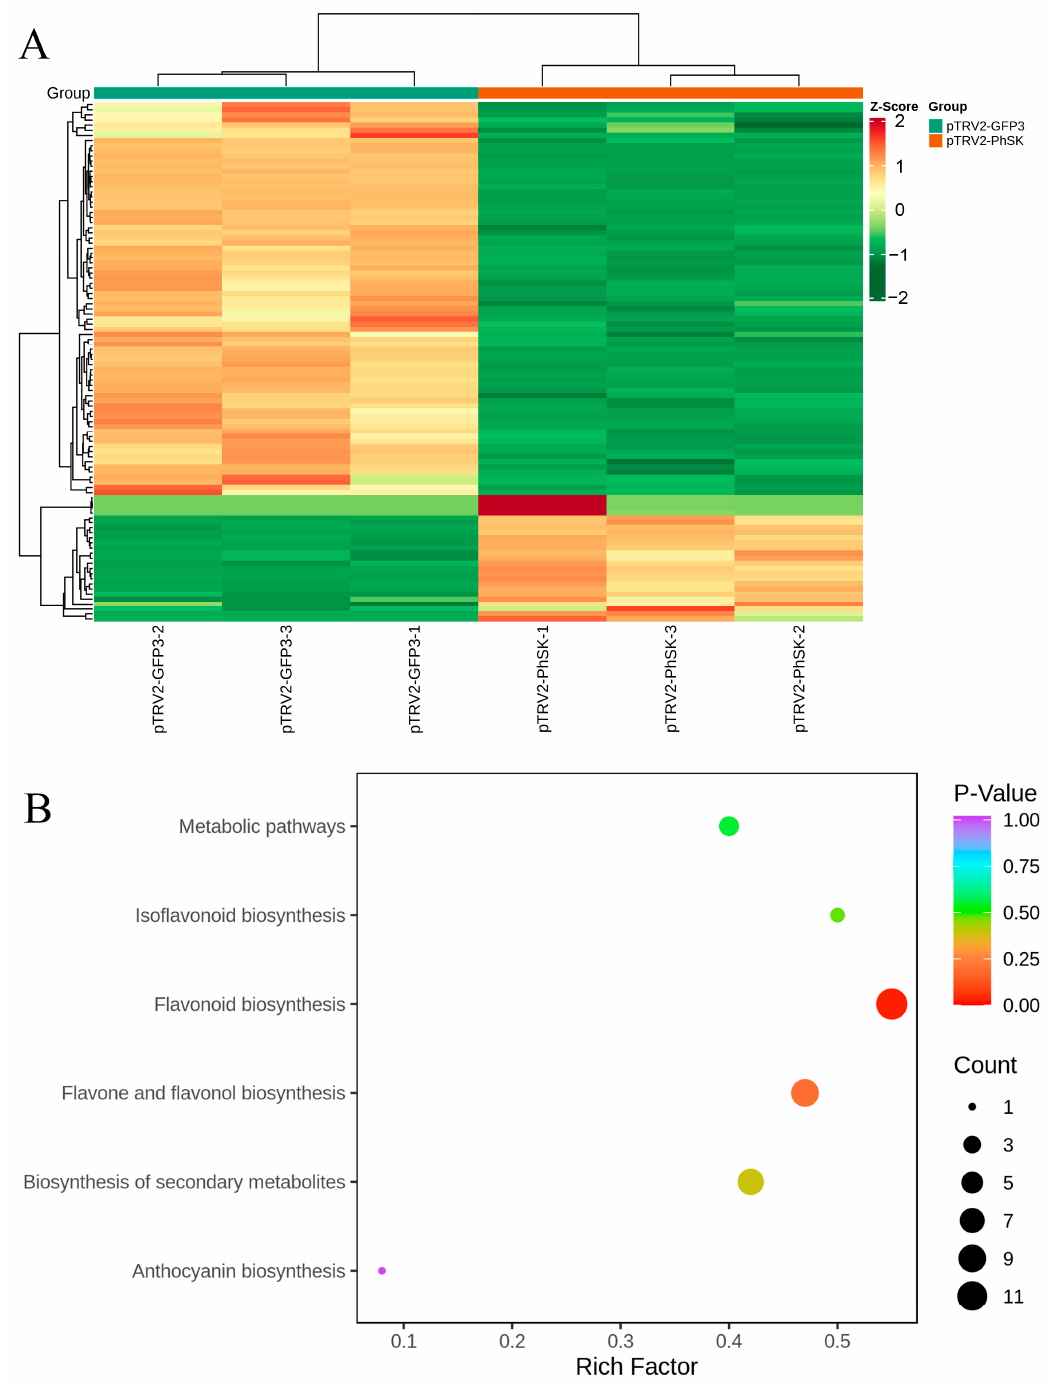
Figure 6. Changes in the corolla flavonoid metabolome profile induced by PhSK silencing. ( A ) Heat map of the differential metabolites in PhSK -silenced compared with control petunia corollas. Green indicates a decrease in differentially expressed metabolites, and red indicates an increase in differentially expressed metabolites. ( B ) KEGG enrichment analysis of the differentially abundant metabolites in PhSK -silenced and control petunia corollas. Data were processed by ggplot2 (version 3.3.0, https://CRAN.R-project.org/package=ggplot2, accessed on 1 November 2022) software.